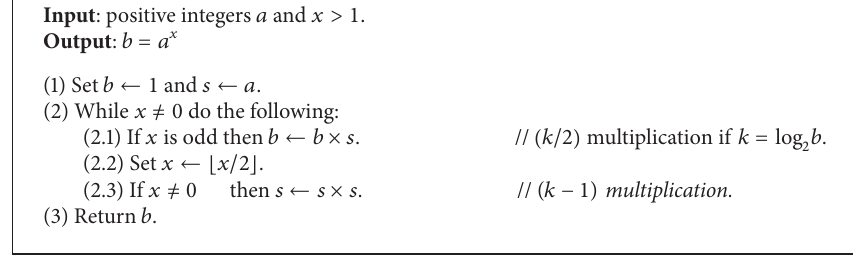
Algorithm 1: Right-to-left binary exponentiation, b = a x .